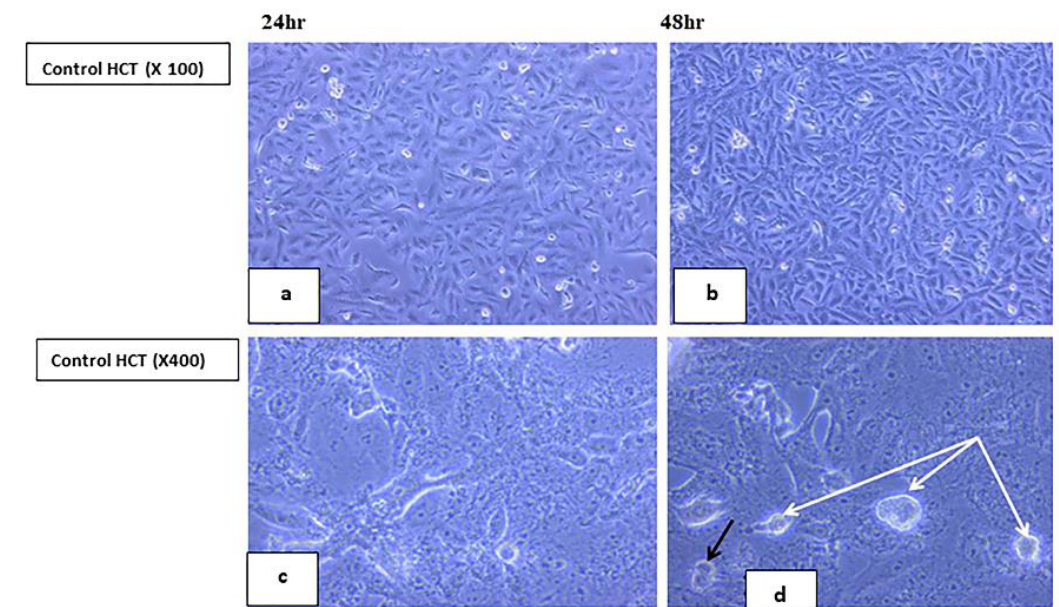
(arrow heads), echinoid spike (black arrow), and some rounded floating disrupted cells. Phase contrast X400.